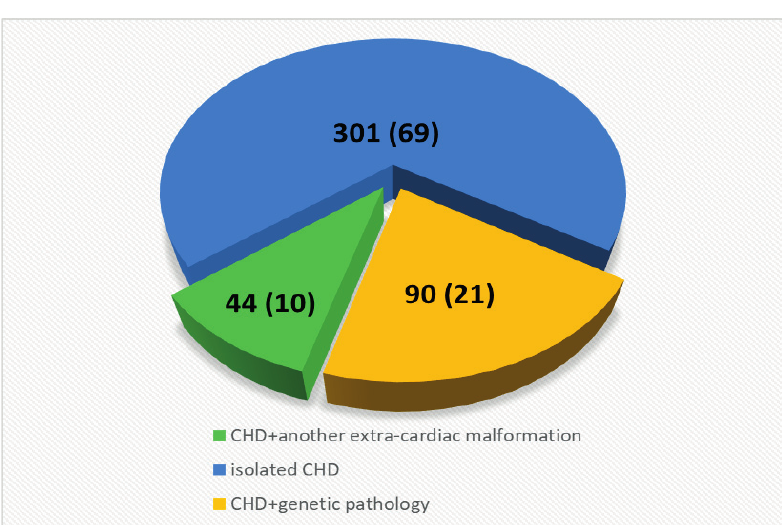
Fig. 4. (A) Prenatally diagnosed CHDs, n (%).